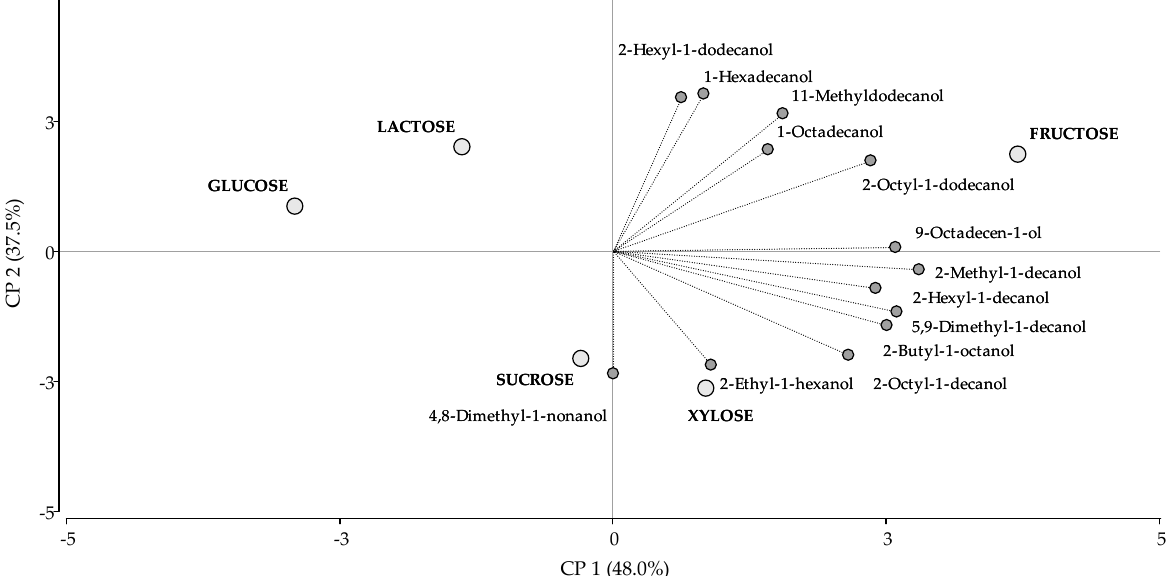
Figure 4. PCA of Straight- and branched-chain alcohols. A total of 18 variables were included: 13 VOCs (dark grey circles) and 5 carbon sources (light grey circles). The first two principal compo- nents accounted for 48.0% and 37.5% of the total variation, respectively.